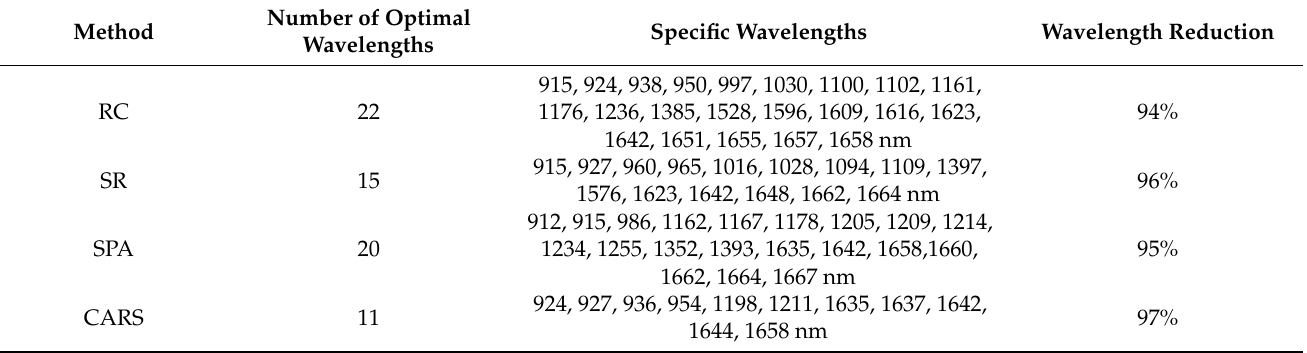
Table 3. Optimal wavelengths selected from NC spectra by RC, SR, SPA and CARS,